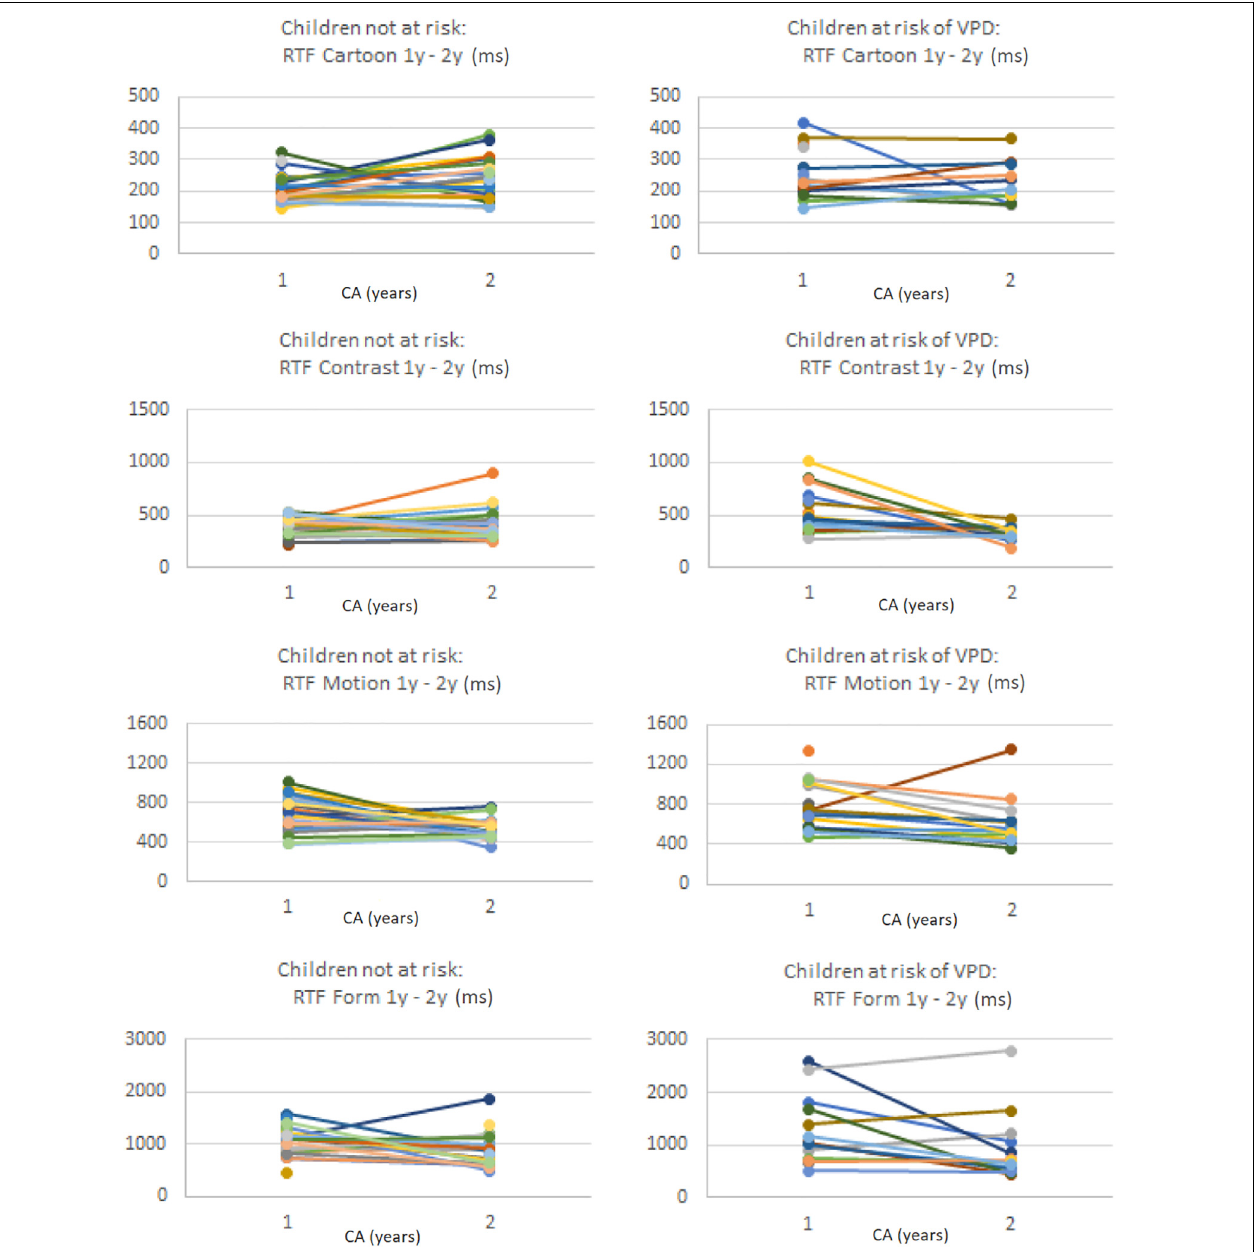
FIGURE 2 | Per stimulus the RTF values (in ms) of individual preterm children at 1 year CA and at 2 years CA, separately for the children without a VPD risk (left column) and the children with a VPD risk (right column) . Note that values on the y -axis differ per stimulus.